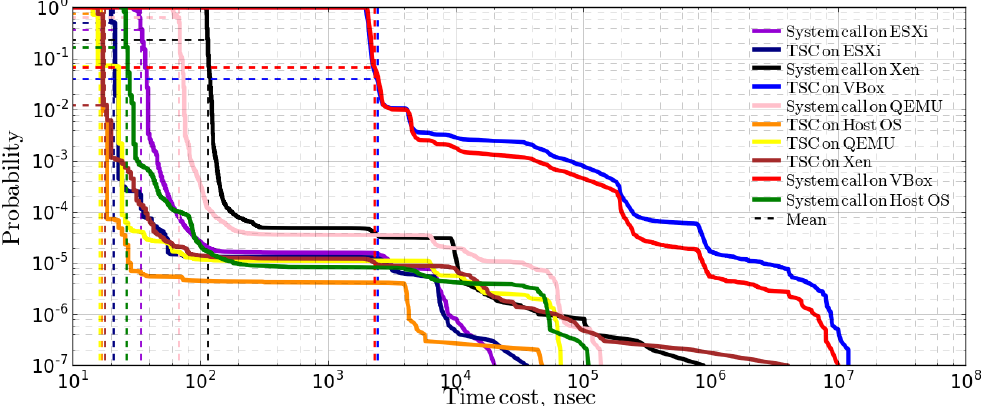
Figure 9. CCDF representation of measurements of time cost for the IO/network